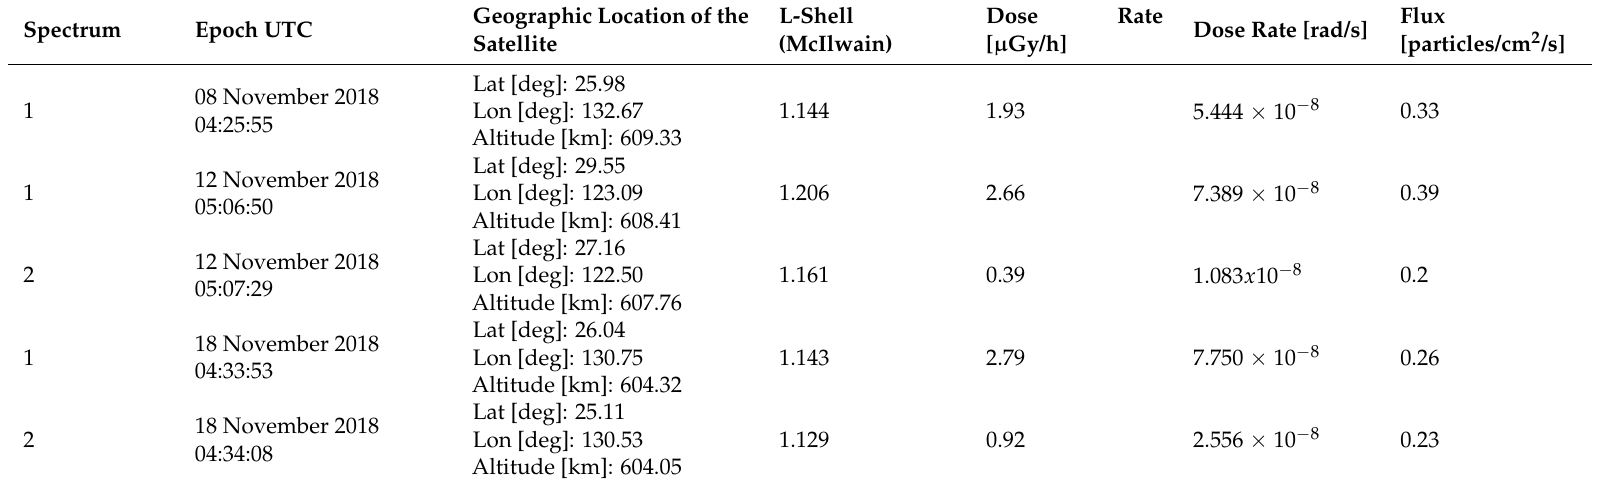
Table 6. The Liulin spectra datasets obtained during real-time operations of the instrument. The measured dose rate and flux where obtained from a total exposition time of 15.286 s for each spectrum dataset. Epoch is in UTC even though the operations were conducted using the Japanese Standard Time (JST). Spectrum Epoch